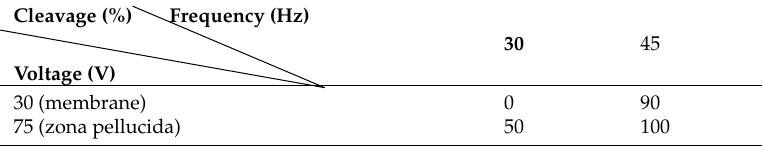
Table 3. Set of experimental results on mouse cells with optimal parameters for second injector.